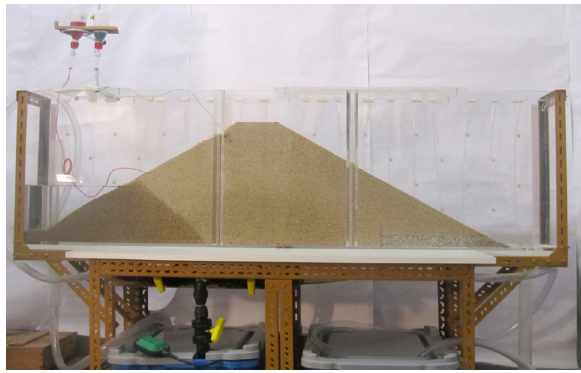
Figure 3. Frontal view of the didactic equipment for seepage studies.